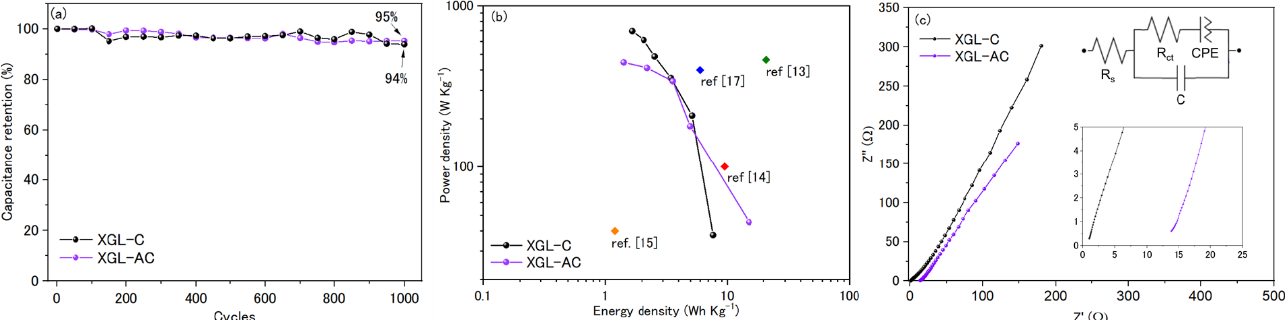
Figure 6. ( a ) Cycling stability of electrodes at 1 A/g and 1 V potential window up to 1000 charge/discharge cycles; ( b ) Energy and power density of the electrodes at current densities ranging from 0.1 to 2.5 A/g; ( c ) Nyquist Plot from EIS.